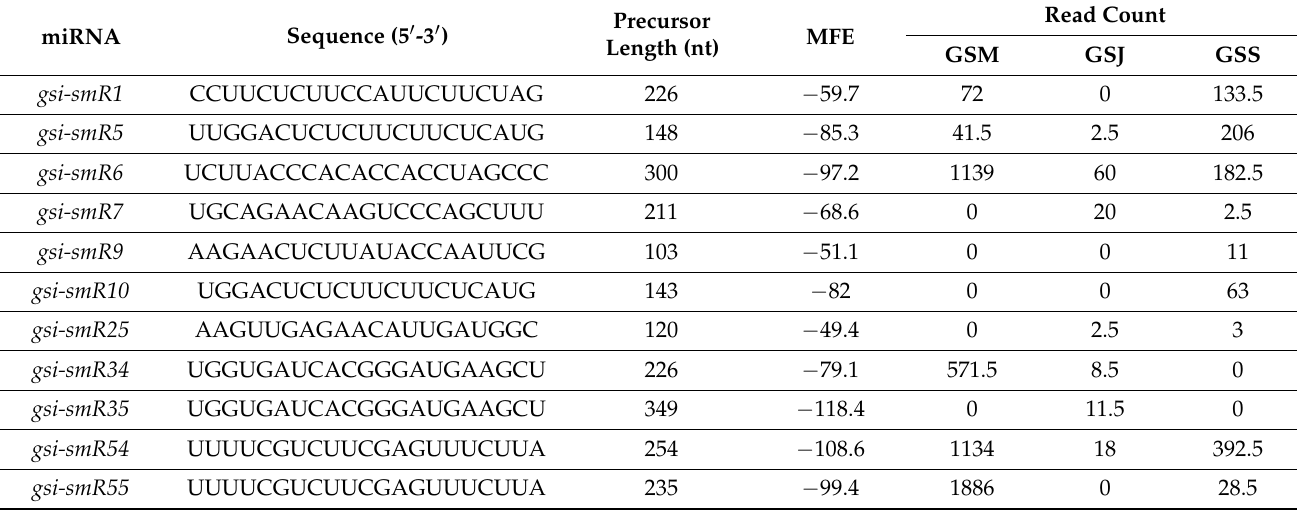
Table 4. Novel miRNAs (part) identified in G. sinensis